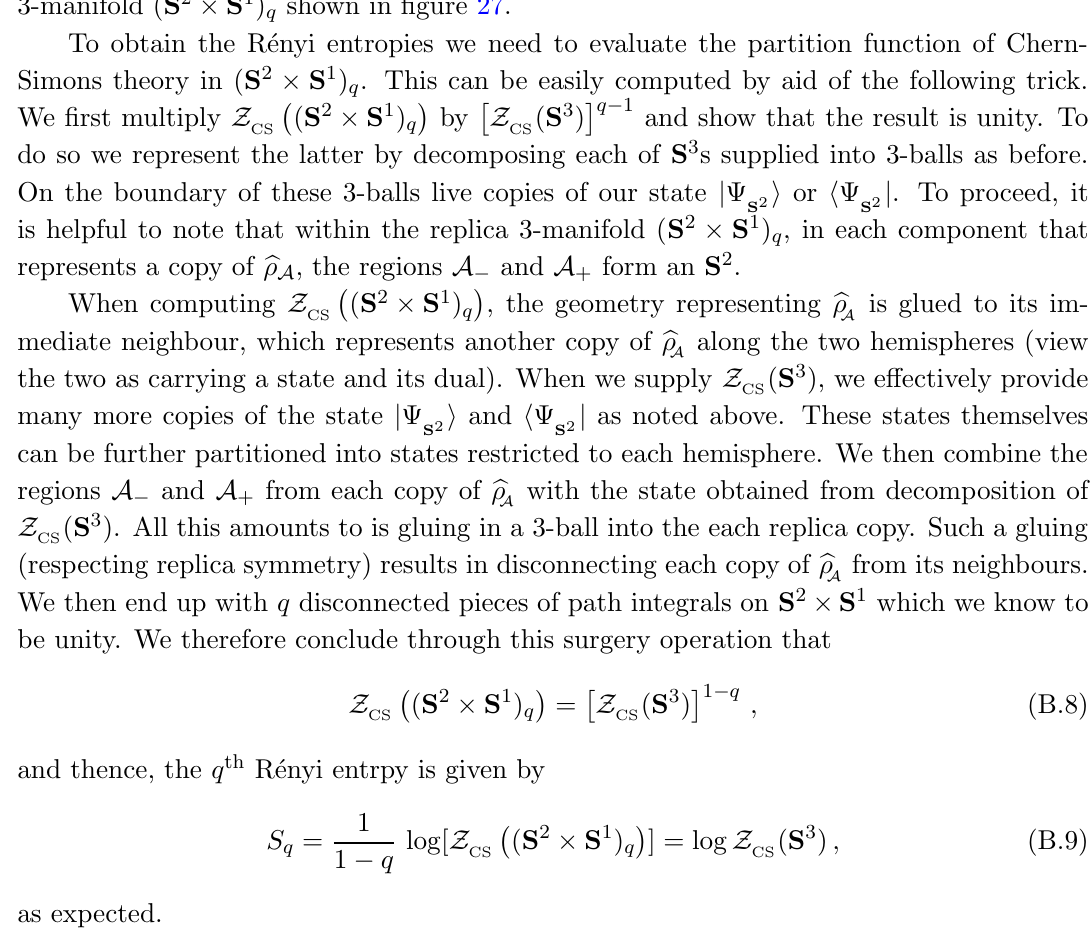
Figure 27 . The q th replica of the normalized reduced density matrix integral over the 3-manifold shown in the